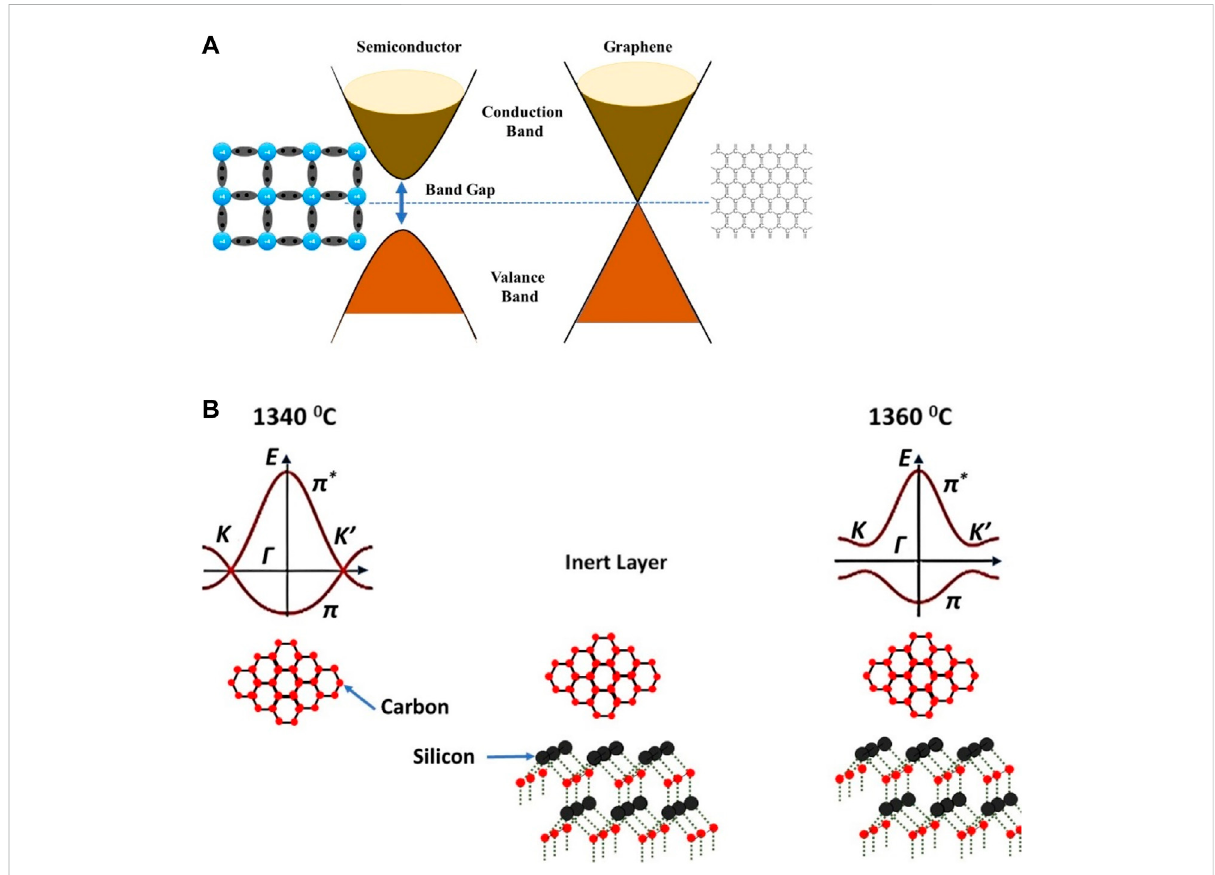
FIGURE 2 EnergybanddiagramofGraphene. (A) ShowszerobandgapbetweenConductionandValanceband. (B) Showsthetemperaturedependencyof the energy band of